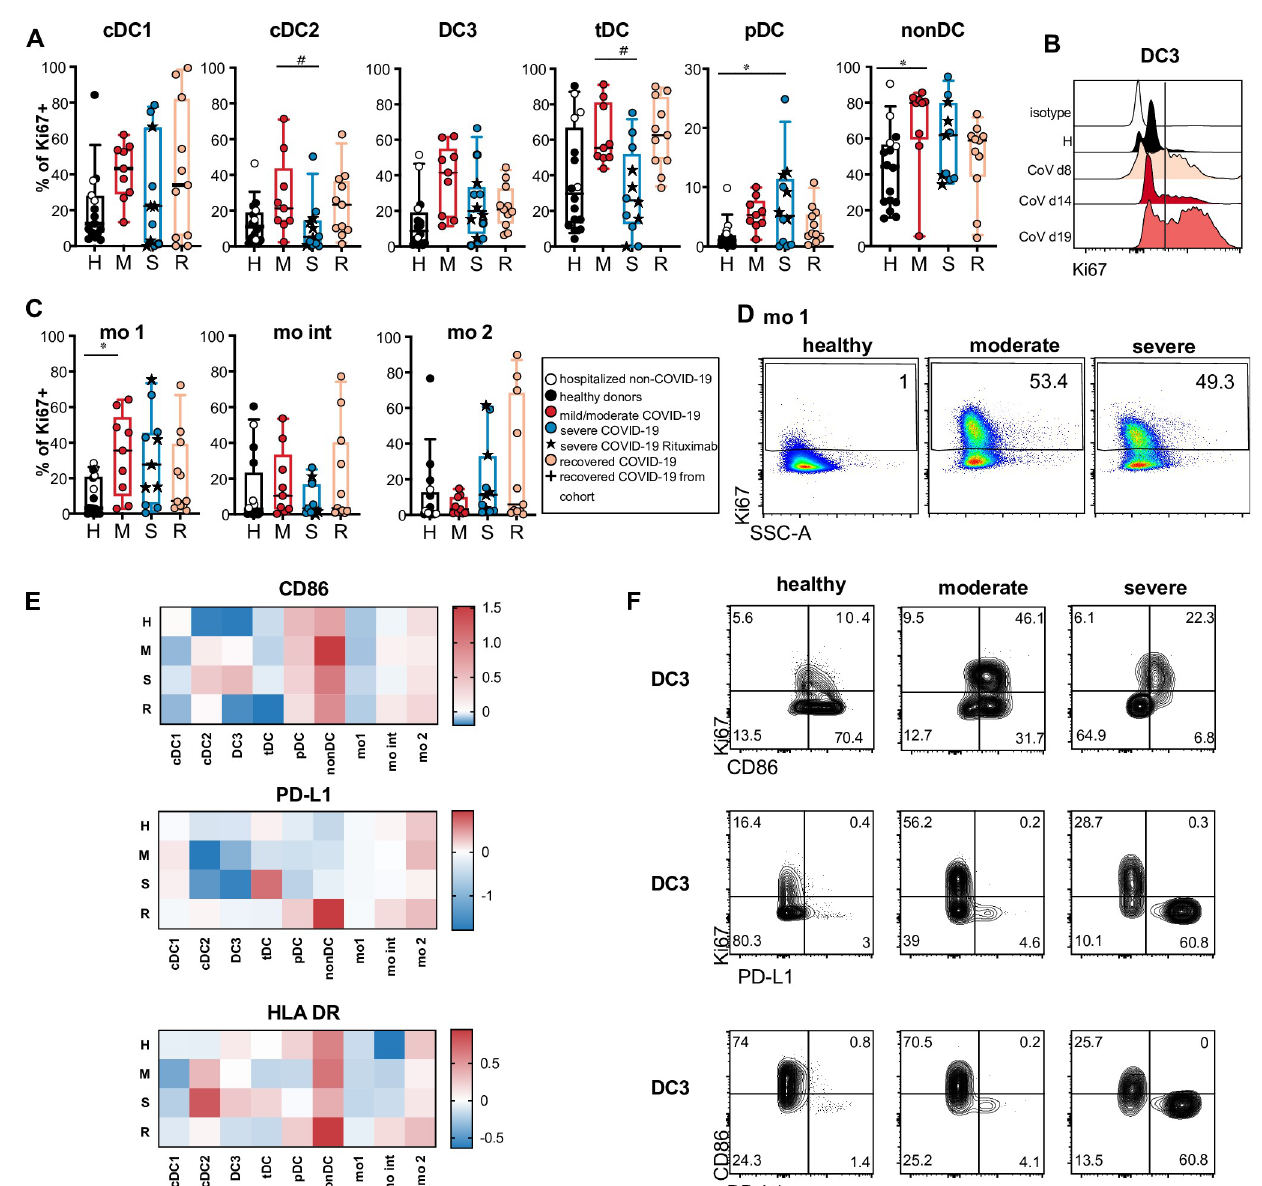
Fig 5. Increased Ki67 expression indicates enhanced turnover and delayed regeneration of DCs and monocytes. (A) Ki67 expression in DC and monocyte subsets was analyzed by intracellular staining and flow cytometry in a subgroup of patients and controls. Healthy donors (H, black, n = 12), hospitalized COVID-19 negative patients (white symbols, n = 4), acute COVID-19 patients with mild/moderate (M, red, n = 9), severe (S, blue, n = 12) disease and recovered patients (n = 11). (A, C) Percentages of Ki67 + cells in each subset are shown (Kruskal-Wallis test with Dunn’s correction, � or # p < 0.05). (B) Representative histogram of Ki67 signal in DC3 in one patient with moderate COVID-19 at different time points after diagnosis. (D) Representative results of Ki67 expression in mo 1 in one healthy, one moderate and one severe patient shown as dot plots. (E) Log2 fold changes of median MFI values of CD86, PD-L1 and HLADR in Ki67 + versus Ki67 – cells within the indicated populations are shown in the heatmaps indicated by the color scale. (F) Representative results of Ki67, CD86 and PD-L1 expression in DC3 of a healthy control, and 2 COVID-19 patients with moderate and severe disease are